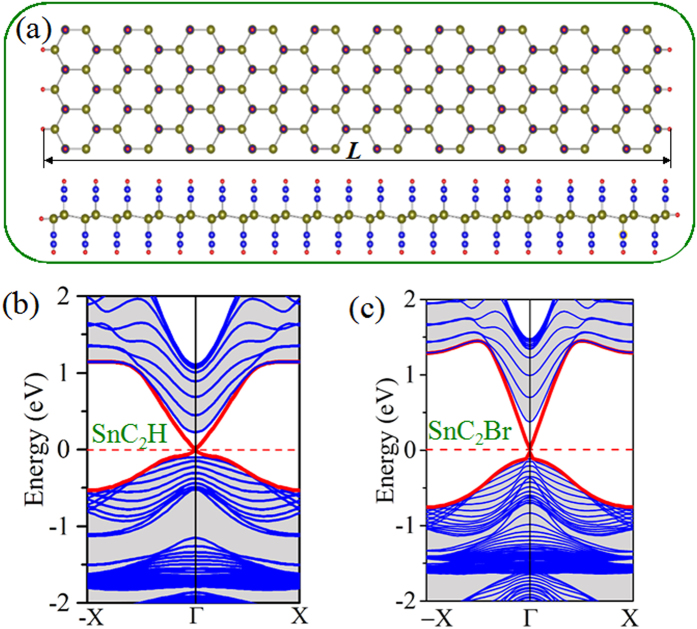
(a) Schematic structure of the zigzag-type nanoribbon of SnC2H and SnC2Br films. (b) and (c) indicate the band structures of zigzag-type edge states in QSH phase. The helical edge states are indicated by the red lines.